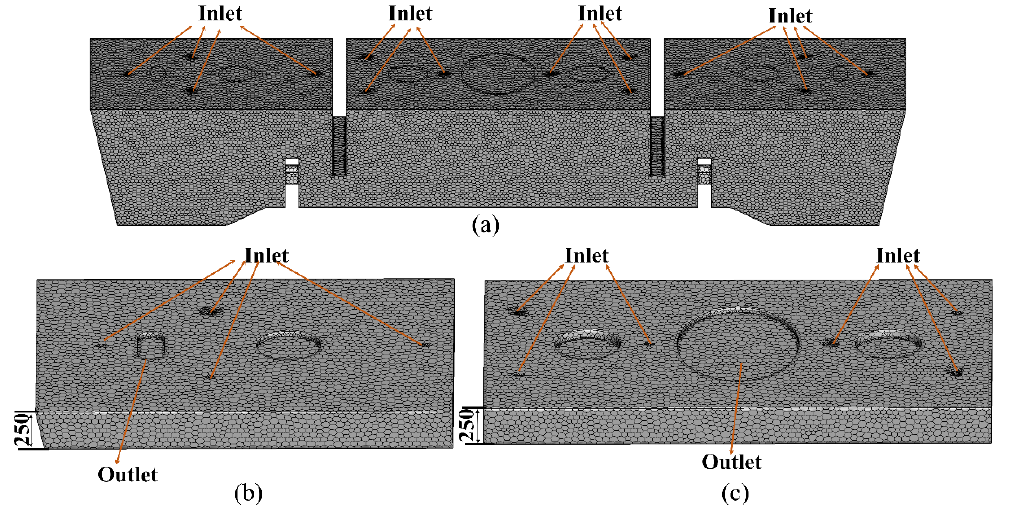
Figure 3. Mesh for empty tundish ( a ), isolated casting chamber ( b ), and isolated injecting chamber ( c ) (mm).